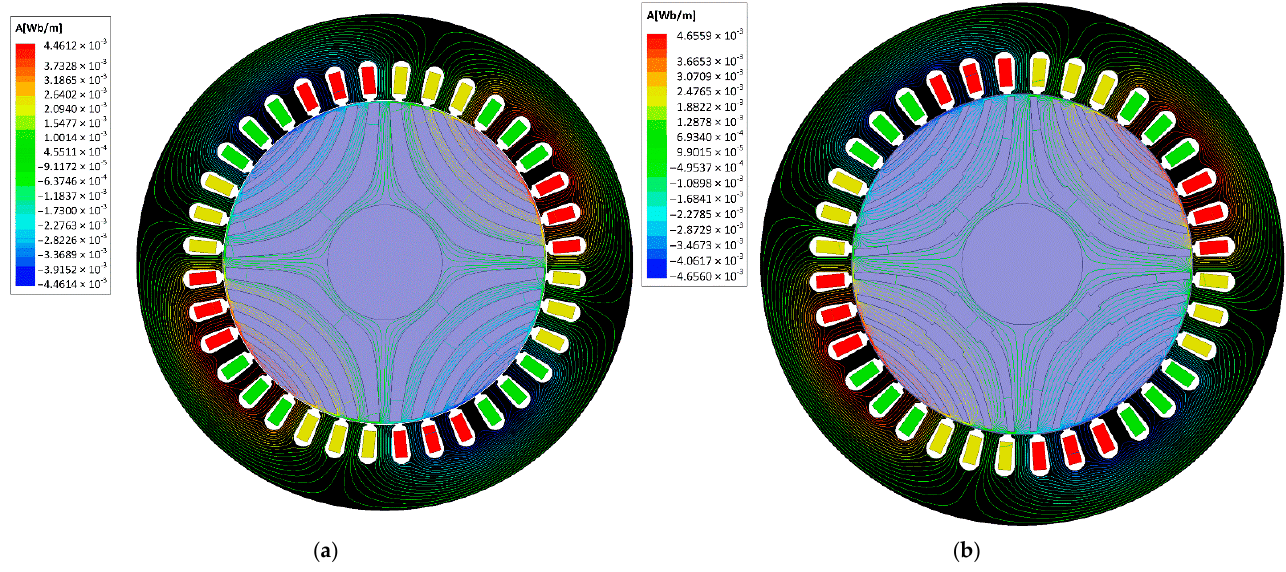
Figure 14. Flux line distribution: ( a ) initial motor; ( b ) proposed